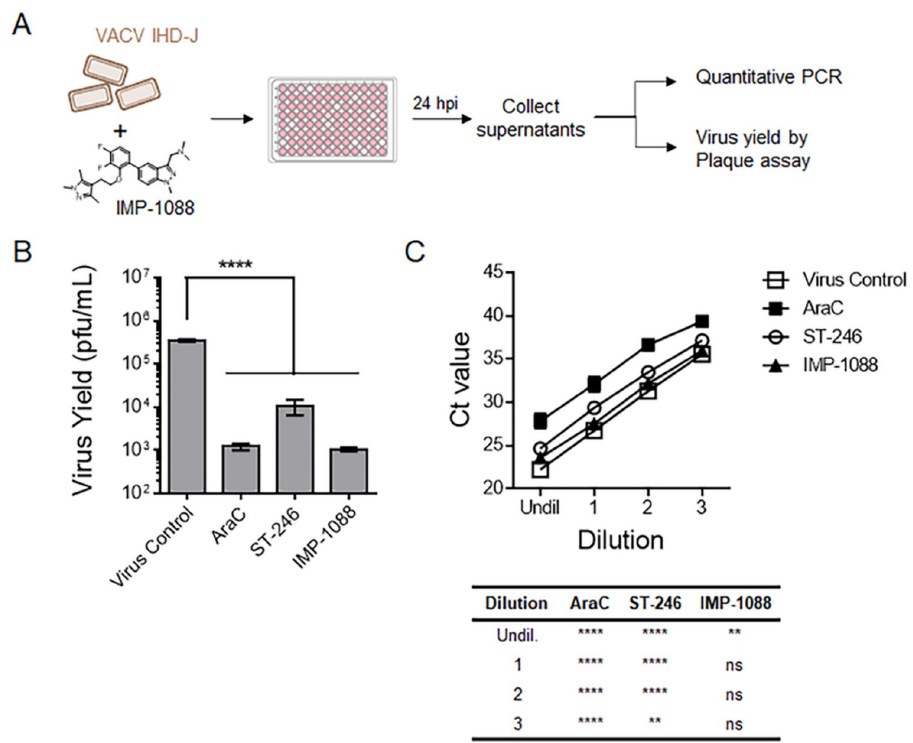
Fig 5. IMP-1088 reduces EV infectivity without directly affecting yield. (A) Schematic representation of assays used to assess VACV EV production after treatment with IMP-1088. (B) BSC-40 cells were infected with VACV IHD-J in presence of inhibitors 40 μ g/mL AraC, 2 μ M ST-246 and 2 μ M IMP-1088 for 24 h. The culture media was collected, spun at low speed to remove debris and cells, and tested by plaque assay to determine virus yield (pfu/mL). Three replicates were tested per viral dilution for each treatment, and the mean values +/- SD are shown. (C) Total viral DNA in the culture media for all four treatments was quantified by DNA isolation followed by qPCR. Four replicates per dilution were tested for every treatment, and the means +/- SD are shown. In both B and C, a one-way ANOVA was performed to determine statistical significance, followed by Tukey’s multiple comparisons test. Ns = not significant, �� = p � 0.005 and ���� = p <